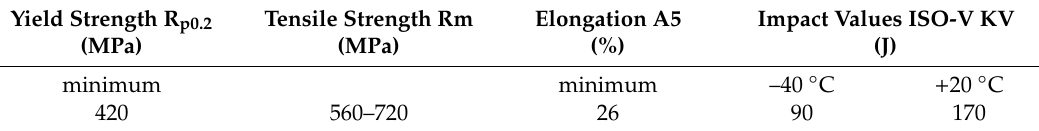
Table 4. Mechanical properties for the weld deposit with E 50 4 B 4 2 H5.